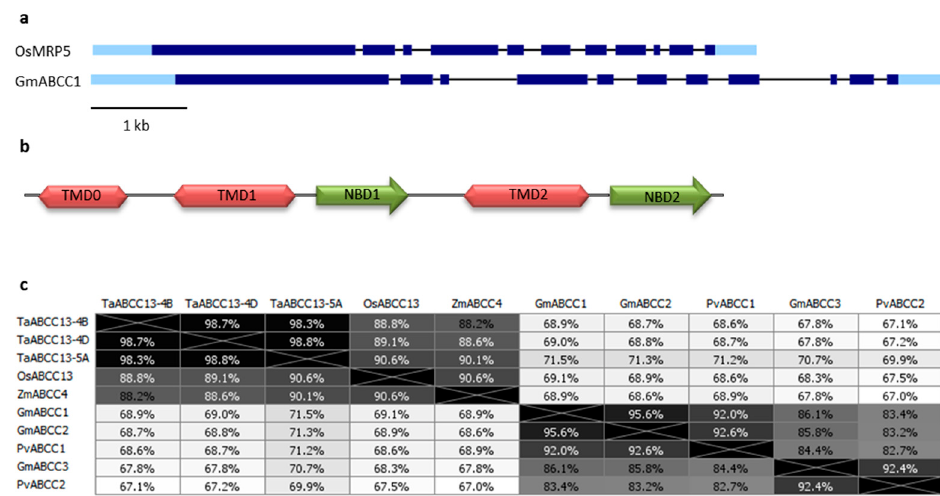
Figure 1. ( a ) Gene structure of OsMRP5 and GmABCC1 genes, as an example of a cereal and a legume PA-MRP gene, respectively. Light and dark blue rectangles represent UTRs and coding exons, respectively, the black bars correspond to introns. Gene Structure Display Server [46] was used; ( b ) Predicted domains of the PA-MRP protein. The transmembrane domains (TMD) and the nucleotide-binding domains (NBD) are represented in red and green, respectively. The structure of the PA-MRP proteins was previously described [17]; ( c ) Distances between PA-MRP proteins, expressed as a percentage of identity. Phylogenies were constructed with the Geneious Tree Builder tool, using the Jukes—Cantor distance model, neighbor-joining tree build method.